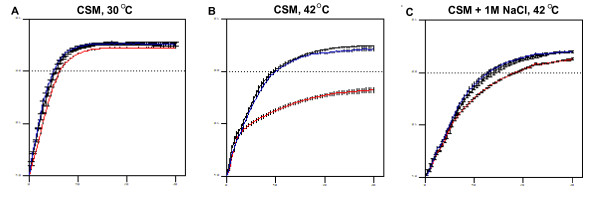
Characterization of growth of the sur7Δ null mutant strain. The growth of strains DAY185 (black), sur7Δ (red), and sur7Δ+SUR7 (blue) were compared under different conditions. Standard growth conditions at 30°C in complete synthetic medium (CSM) supplemented with uridine is shown in (A). Growth at extreme temperature (42°C) was also tested in CSM supplemented with uridine (B) and CSM with 1 M NaCl supplemented with uridine (C). At high temperatures (42°C), the impaired growth of the sur7Δ null mutant strain was statistically significant compared to the control strains. All growth curves were performed in triplicate, with Log10 of OD600 plotted against Time (hours). Corresponding error bars are indicated. Table 2 lists the calculated doubling time of each strain under each condition presented here.